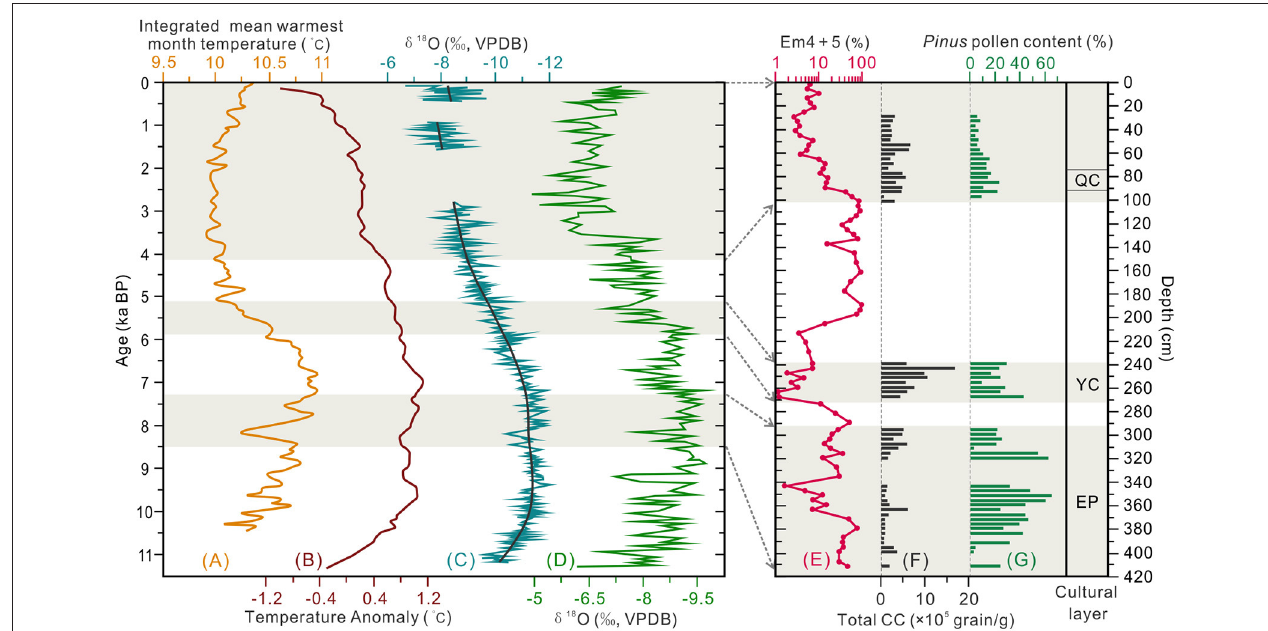
FIGURE 8 | Comparison of the Environmental proxies from the section T1406E (Shalongka site) with nearby climate records. (A) Integrated reconstruction of Holocene mean warmest month temperature in eastern Qinghai–Tibetan Plateau ( Liang et al., 2020); (B) Quantitative reconstruction of Holocene temperature record in the northern hemisphere (90–30 ◦ N) (Marcott et al., 2013); (C) Holocene monsoon changes recorded by high-resolution stalagmites on the western Chinese Loess Plateau ( Tan et al., 2020); (D) δ 18 O record of the Asian monsoon from Dongge cave, Guizhou Province, China (Dykoski et al., 2005); (E) EM4 + 5 score mean grain-size of the section T1406E; (F) Total charcoal concentration (CC) of the section T1406E (G) Pinus pollen content of the section T1406E. EP, Epipaleolithic; YC, Yangshao culture; QC, Qijia